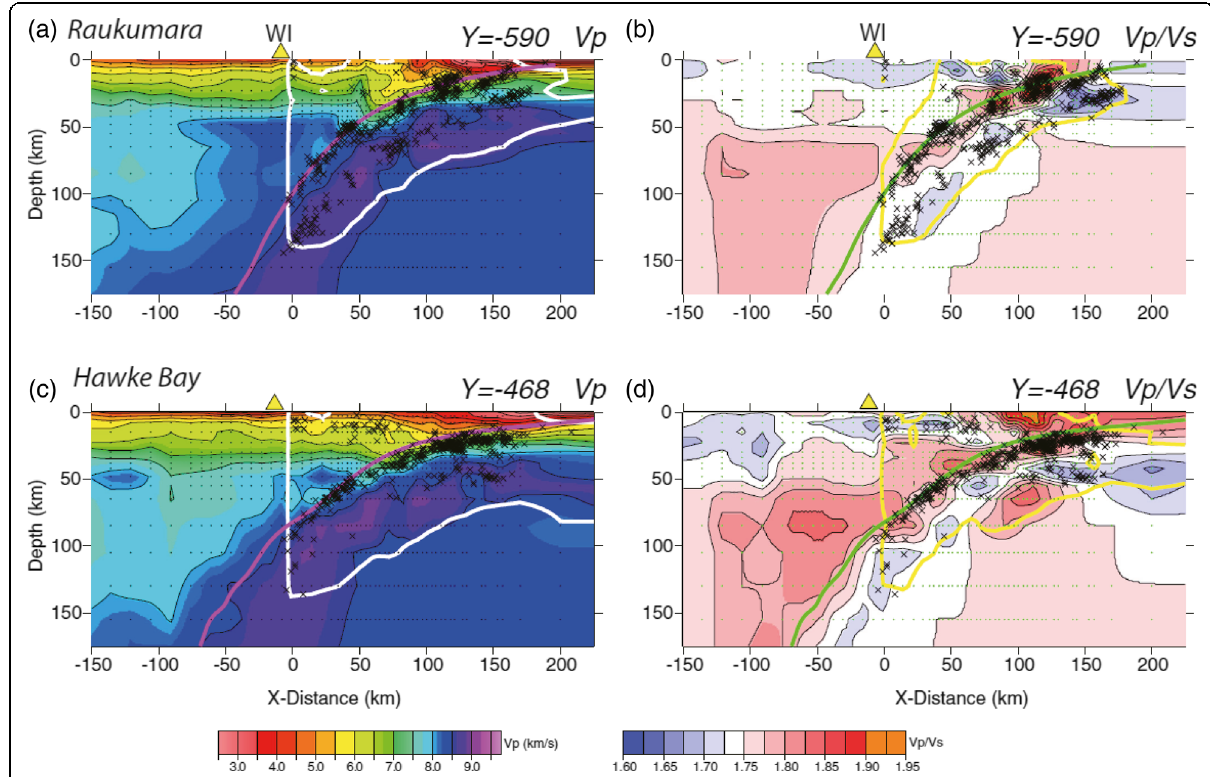
Fig. 15 P-wave velocity and Vp/Vs ratio structures in northern Hikurangi, New Zealand (Eberhart-Phillips and Bannister, 2015). P-wave velocity and Vp/Vs values are shown on across-arc vertical cross-sections by the color scales at the bottom in a and c and b and d , respectively. a – b Raukumara Peninsula and c – d Hawke Bay. White and yellow lines denote the limit of resolution for the spread function = 3.5. Earthquakes and volcanoes are shown as crosses and triangles , respectively. Magenta and green lines show the upper surface of the